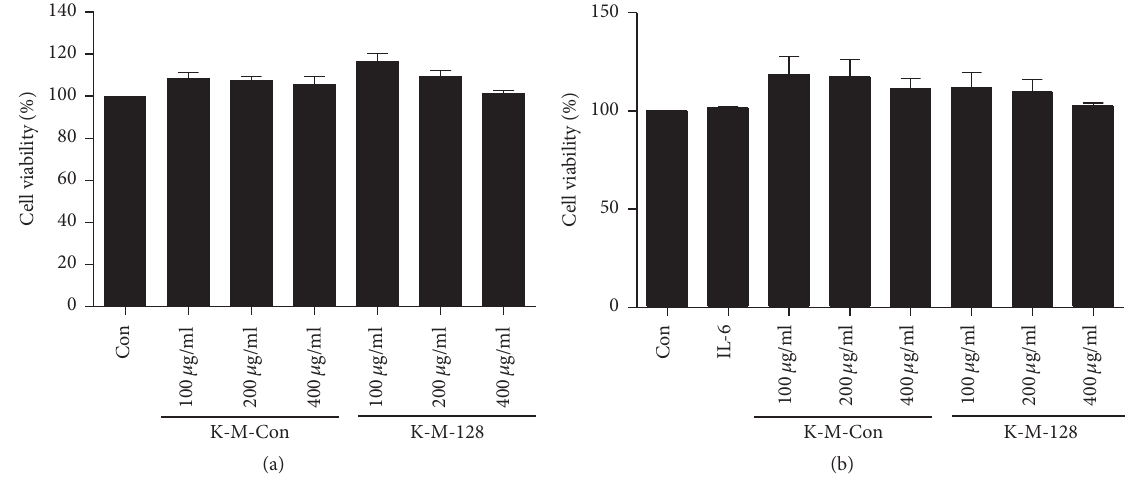
Figure 2: Effects of IL-6 and KIOM-MA/MA128 on cell viability of Caco2 cells. Cells were pretreated with various concentrations (100– 400 𝜇 g/ml) of KIOM-MA/MA128 for 1h and treated with IL-6 (50 ng/ml) for 24 h. Cell viability was determined using a Cell Counting Kit-8. Cell viability is represented as the percentage relative absorbance compared with the controls. (a) Cell viability of KIOM-MA/MA128; (b) cell viability of KIOM-MA/MA128 with IL-6 (50ng/ml). The results are represented as the means ± SDs of three independent experiments, and 𝑡 -tests were